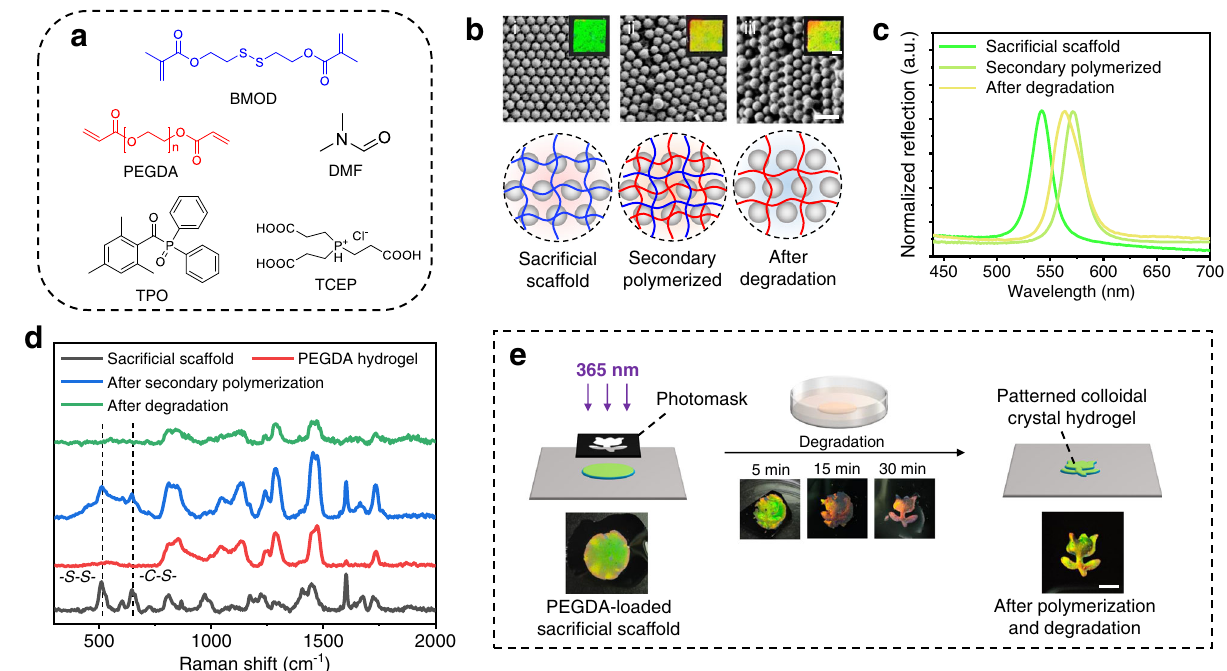
Fig. 2 | Colloidal hydrogel fabrication using the sacri fi cial scaffold. a Chemical structure of the reagents used. b Optical and SEM images of the (i) sacri fi cial scaffold, (ii)secondarypolymerizedhydrogel, and (iii) hydrogelafterdegradation. Scale bars: 2mm for optical images and 500nm for SEM images. c Normalized re fl ection spectraof the hydrogels in b . d Ramanspectrum ofthe PEGDAhydrogel